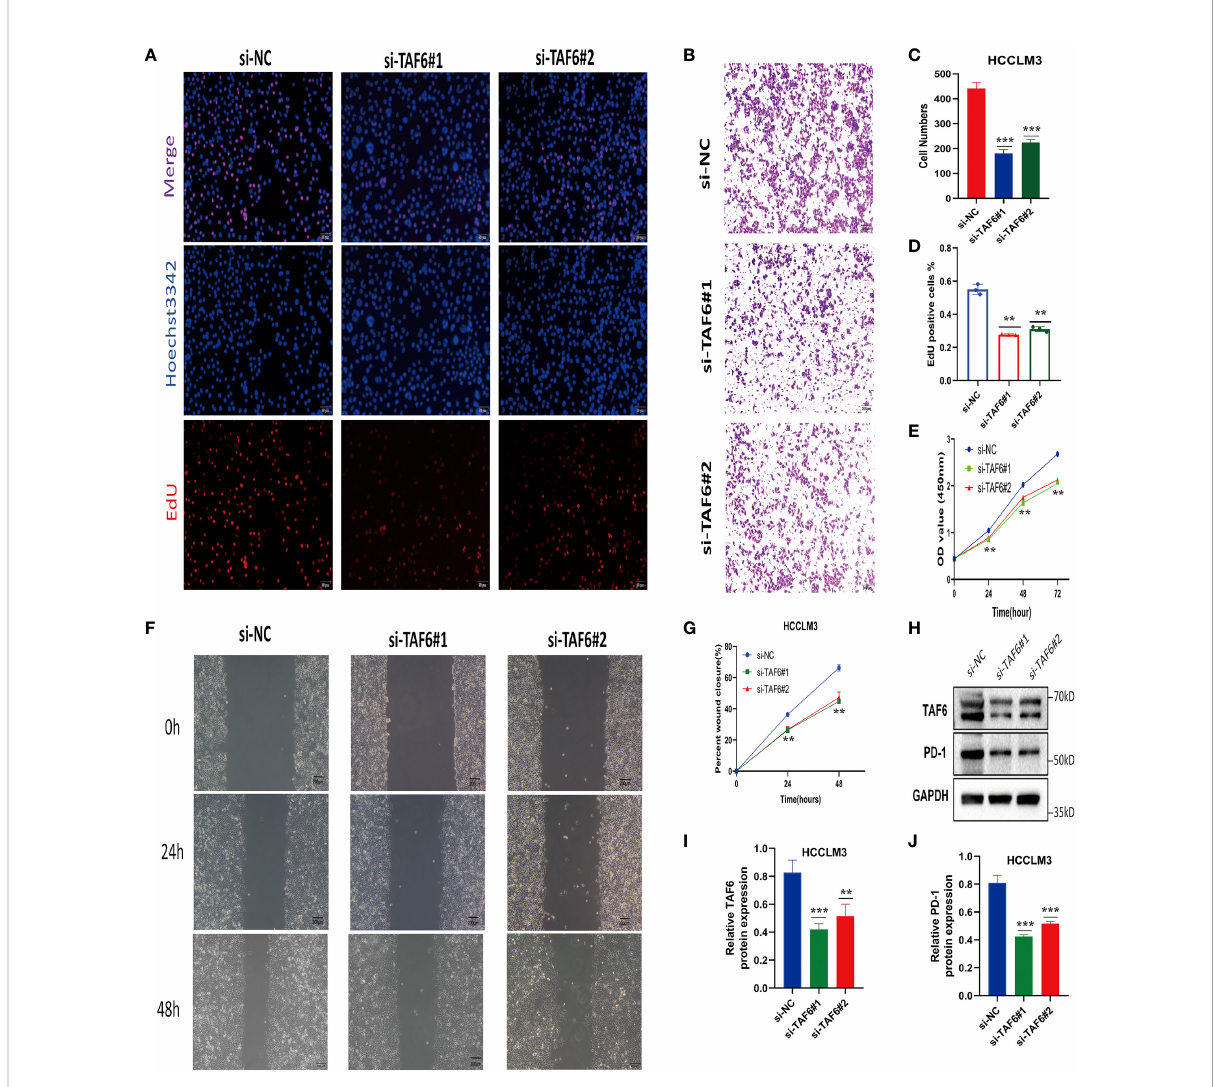
FIGURE 13 Adverse effects of TAF6 on HCC in vitro . (A, D) Compared with the control group, the proliferation rate of HCCLM3 cells was signi fi cantly inhibited after TAF6 silencing by EdU staining. (B, E) Transwell experiments showed that the migratory ability of HCCLM3 was inhibited after TAF6 silencing. (C) After TAF6 silencing, the cell viability of HCCLM3 was signi fi cantly inhibited by the CCK- 8 assay. (F, G) The wound healing array showed that LTAF6-downregulated HCCLM3 cells exhibited signi fi cantly delayed wound healing compared with controls. (H – J) Effects of with or without inhibition of TAF6 expression on PD-1 protein expression levels by western blotting. Scale bar: EdU,50 m m; Transwell experiments and Wound healing array,200 m m. **p<0.01,